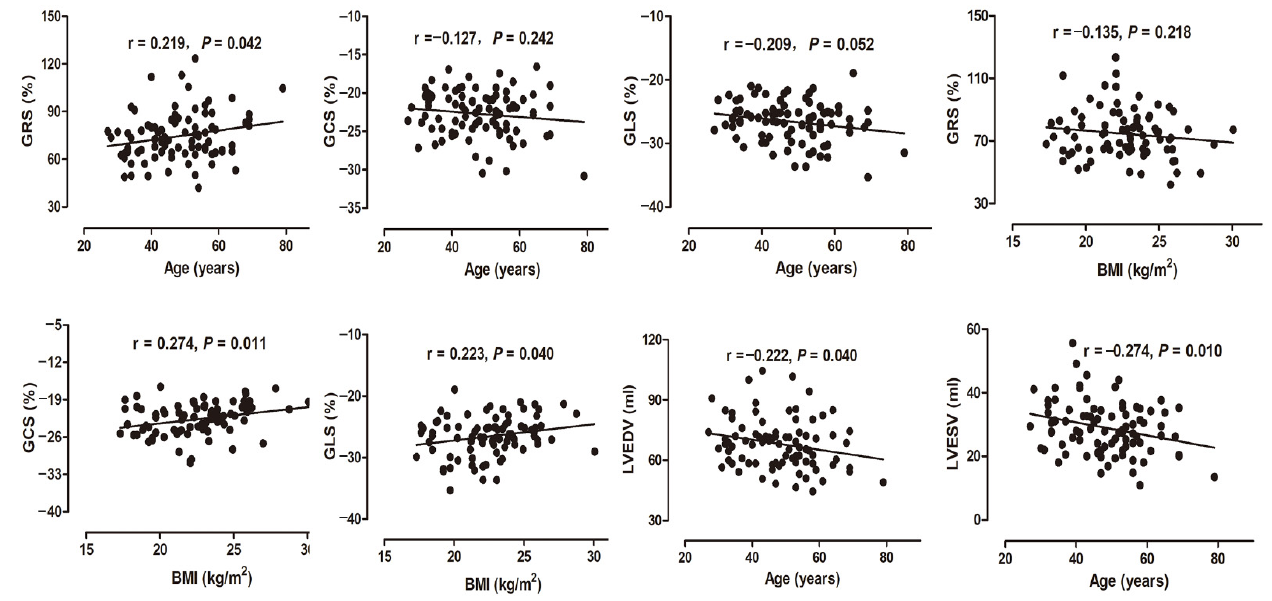
Figure 5. The correlation between left ventricular strain with age and BMI, and the correlation between LVEDV and LVESV with age. GRS: global radial strain; GCS: global circumferential strain; GLS: global longitudinal strain. LVEDV: left ventricular end-diastolic volume; LVESV: left ventricular end-systolic volume; BMI: body mass index.